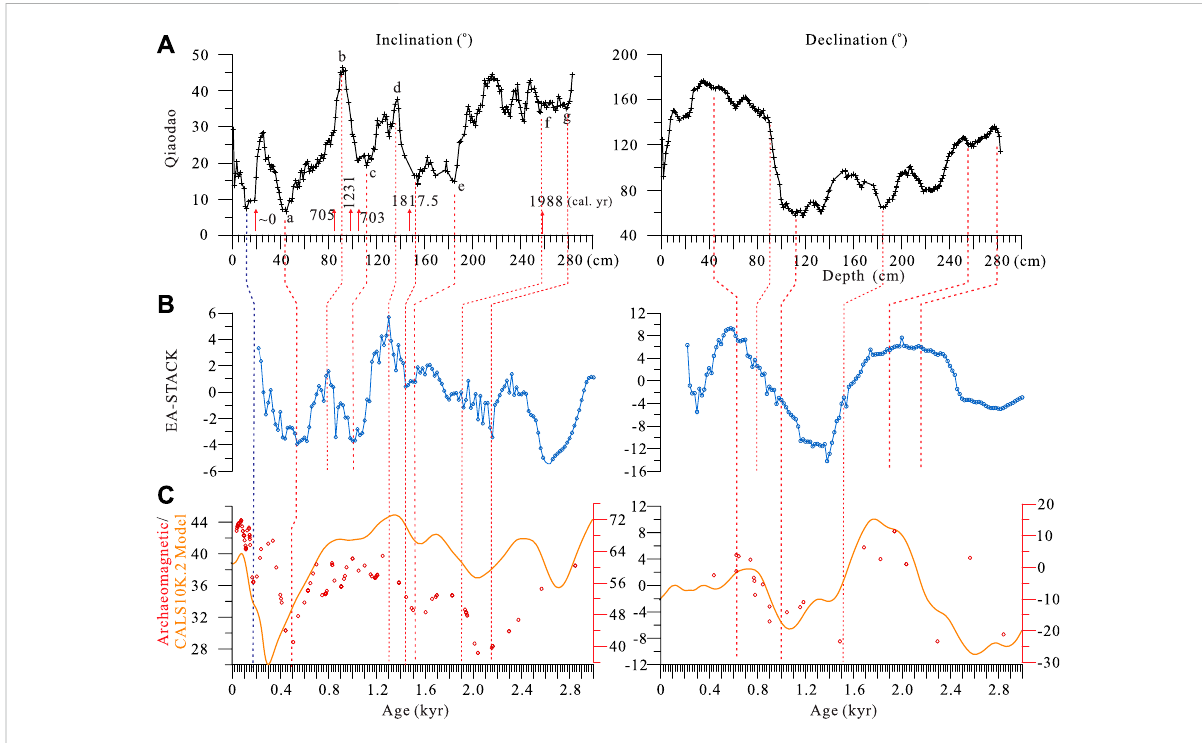
FIGURE 7 CorrelationoftheChRMdirectionsofcoreZH06 (A) witheasternAsianstackcurves(EA-STACK)(ZhengJetal.,2014) (B) andarchaeomagnetic/ CALS10k.2 model results of eastern China (Brown et al., 2015) (C) . The radiocarbon ages are displayed in (A) . The dotted lines show the favorite tied points between the different